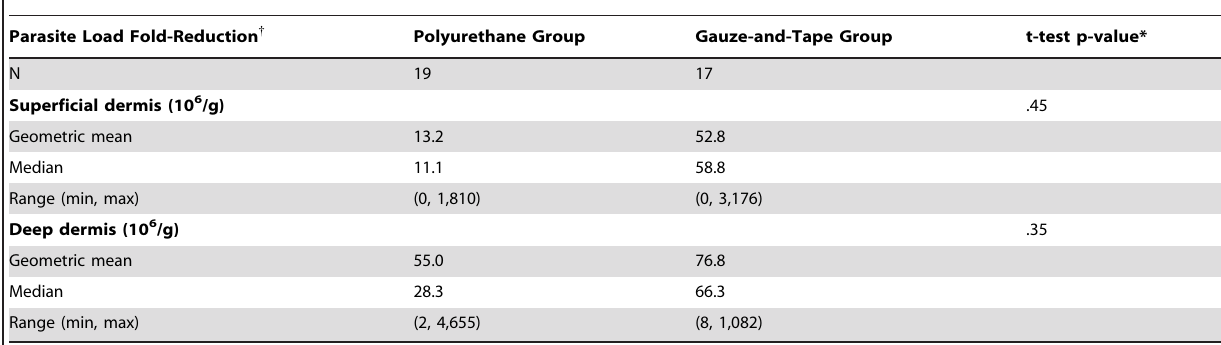
Parasite Load Fold-Reduction { Polyurethane